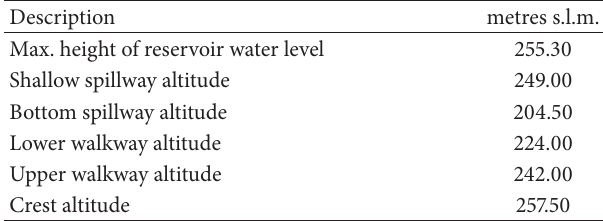
Table 1: Geometric features of Punta Gennarta Arch